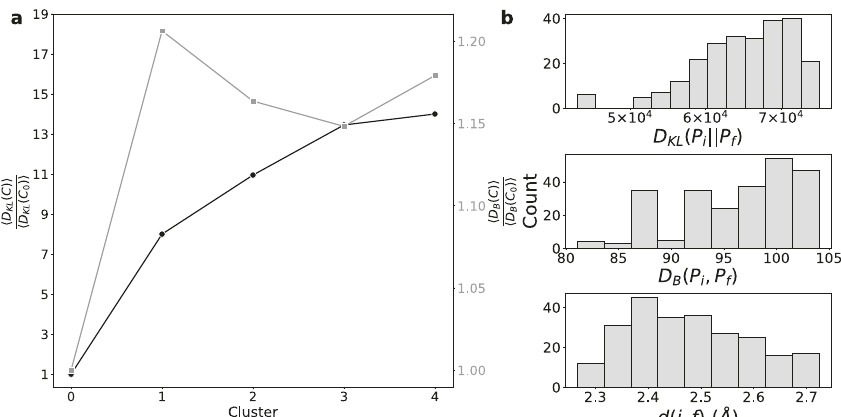
Fig. 5 Similarity measures for clusters of structures. a Cluster relative average KL divergence and relative average Bhattacharyya distance. b Distribution of the KL divergence, Bhattacharyya distance, and Euclidean distance for the individuals in cluster C 3 .